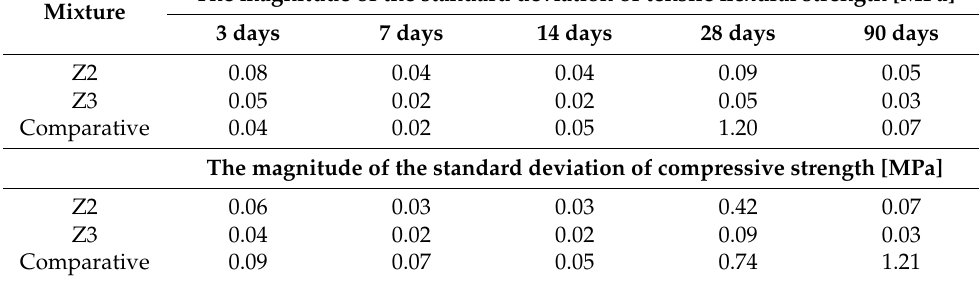
Table 2. The standard deviation of tensile flexural strength and compressive strength of experimen- tal